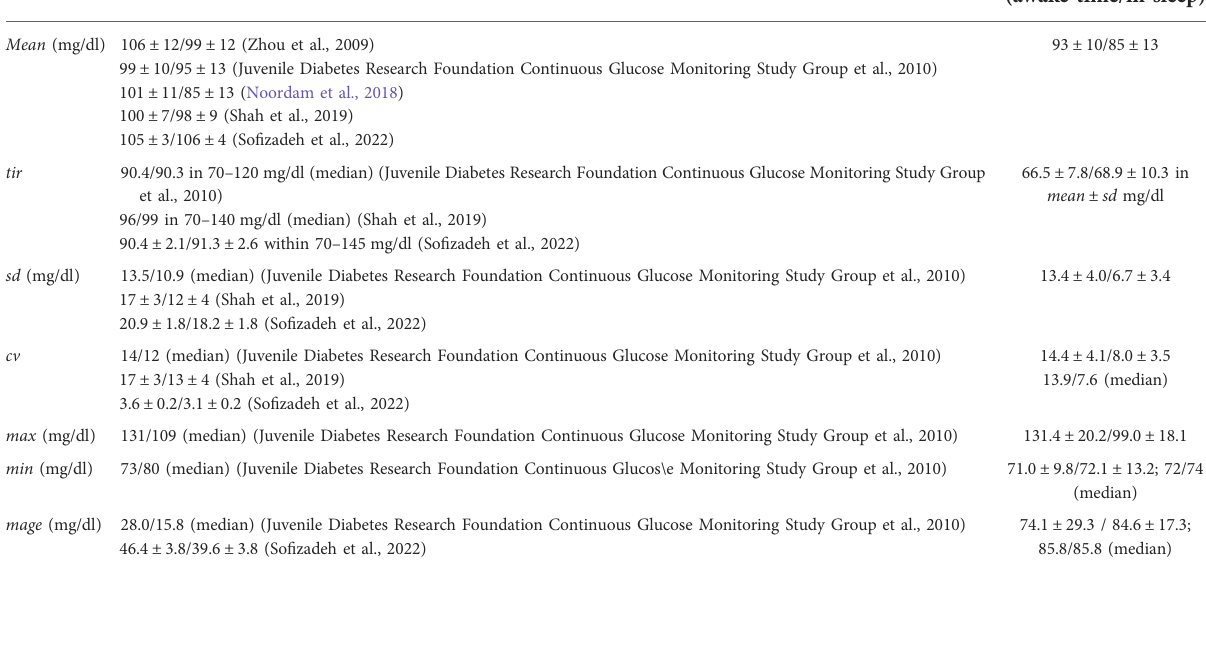
(awake-time/in-sleep)